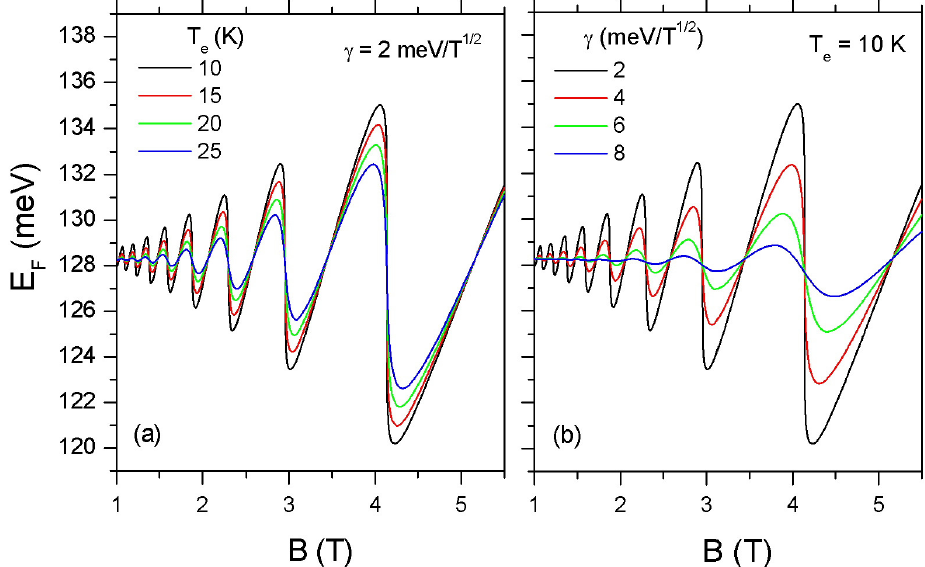
Figure 1. Oscillations of the Fermi energy, E F , as a function of magnetic field in an MLG with sheet density n s = 10 16 m − 2 . In ( a ) the LL broadening parameter γ is taken to be 2 meV/T 1/2 and T e varies between 10–25 K while ( b ) depicts E F for γ = 2,4,6, and 8 meV/T 1/2 at T e = 10